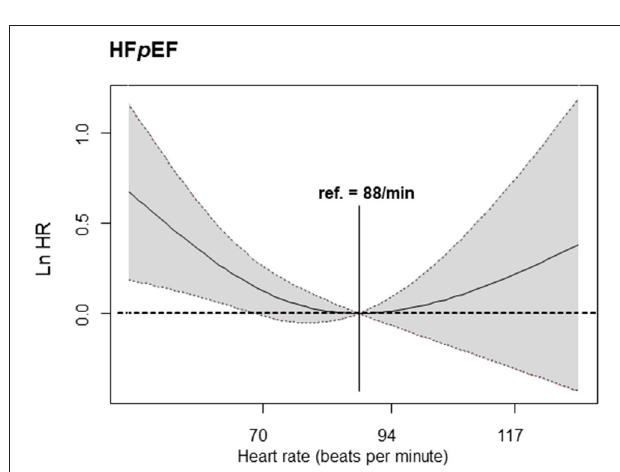
FIGURE 5 | Cox regression analysis—penalized spline. The primary endpoint according to heart failure in patients with HFpEF (reference heart rate of 88 bpm) is shown. HFpEF, heart failure with preserved ejection